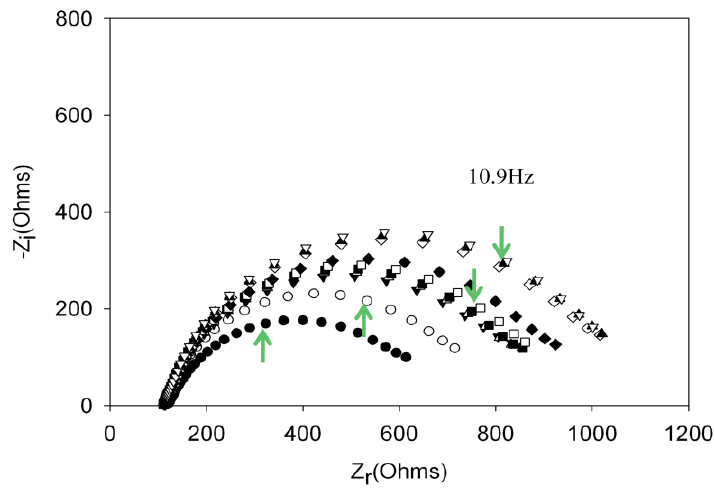
Figure 7. Calibration curve vs. thrombin concentration. (Δ R ct (electrode-buffer)